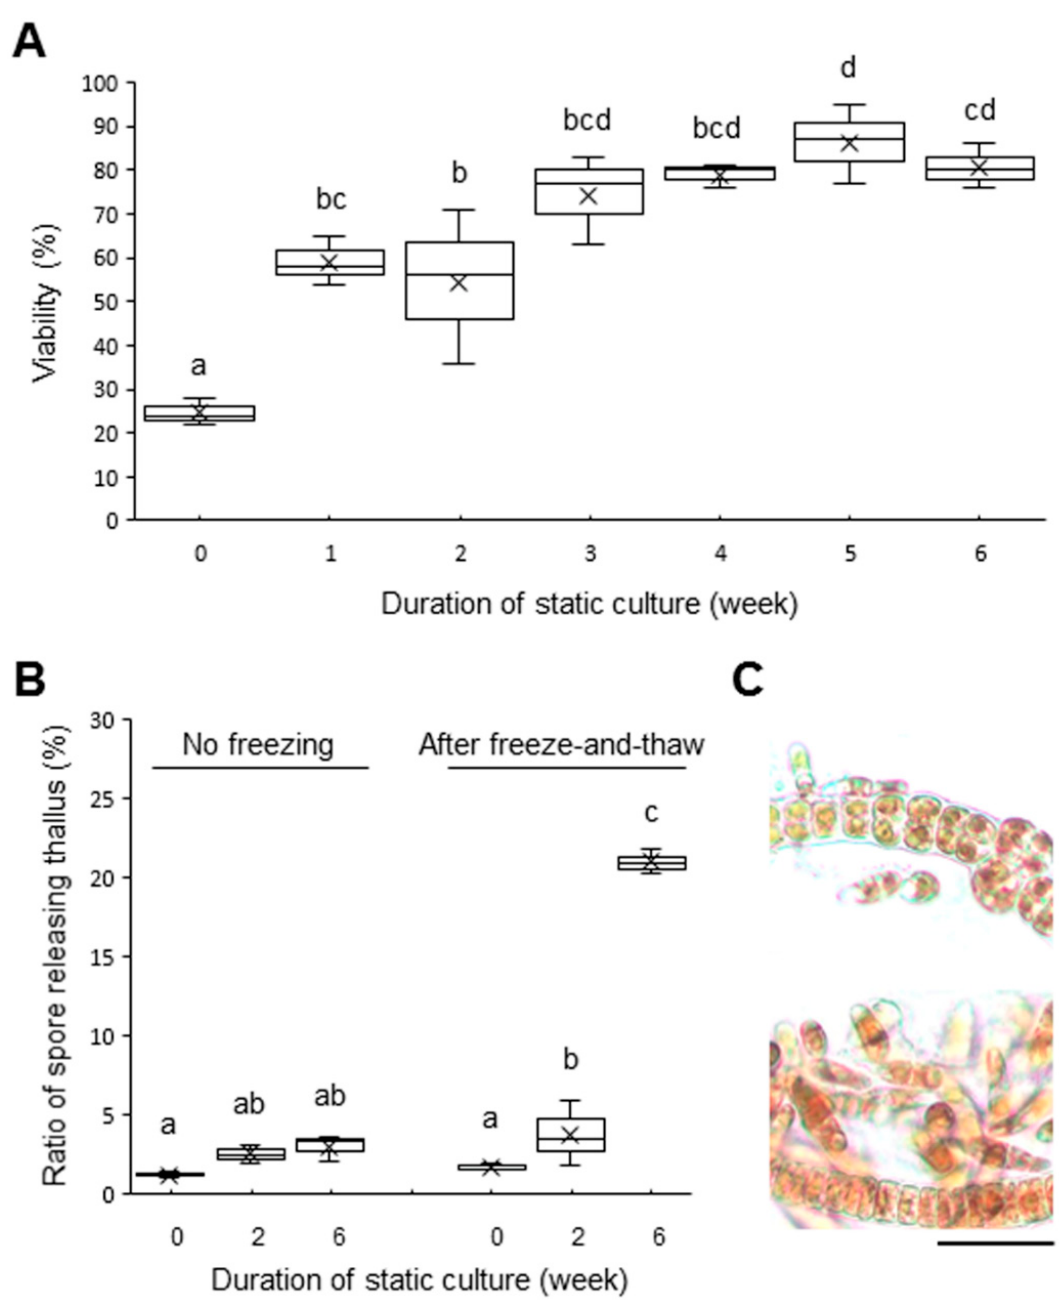
Figure 1. Effects of static culture on viability and release of asexual spores in ‘ Bangia ’ sp. ESS1. ( A ) Static culture-induced increase in viability after freeze-and-thaw. ( B ) Enhancement of release of asexual spores from statically cultured thalli after freeze-and-thaw. ( C ) Extensive release of asexual spores in thalli exposed to freeze-and-thaw treatment (lower) than non-frozen thalli (upper) after static culture for 6 weeks. Most released spores developed into small germlings. Scale bar: 50 µ m. Letters on boxes denote significant differences from triplicate experiments defined by the Tukey–Kramer test ( p < 0.05) in one-way ANOVA.